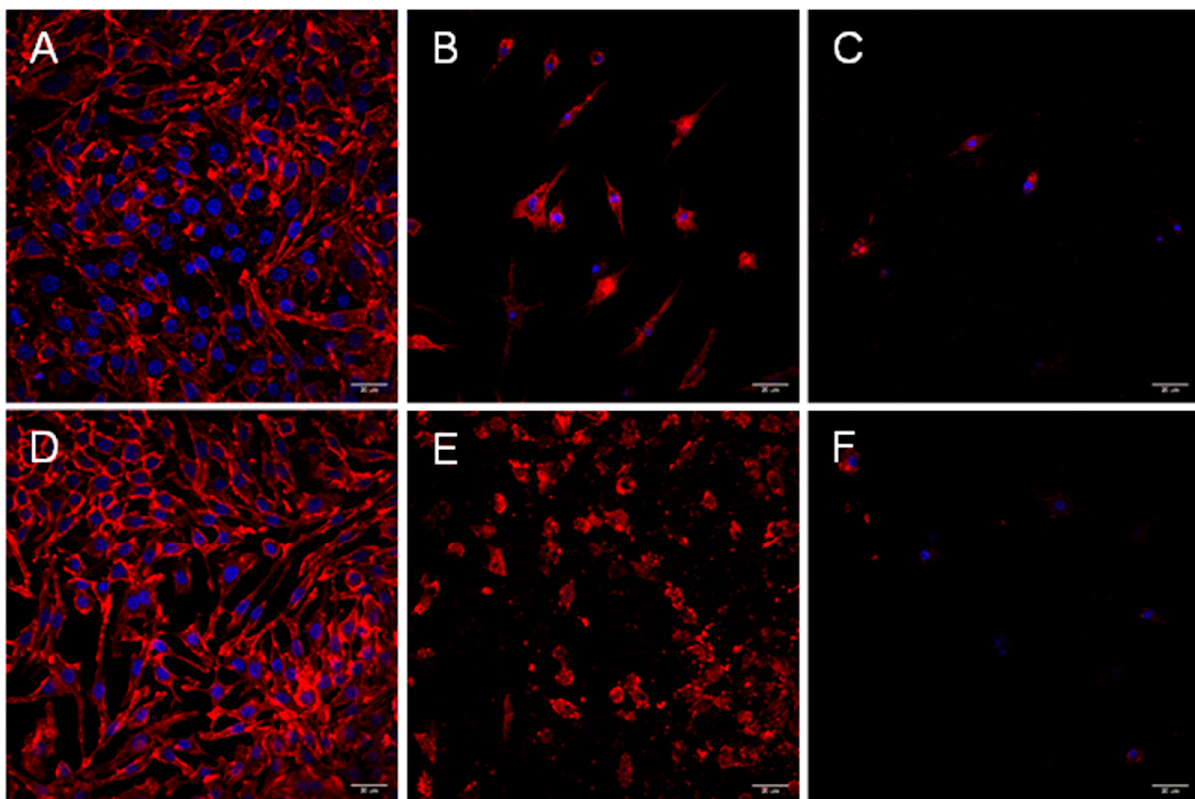
Figure 3. Aeromonas strains trigger a cytotoxic effect during infection of mouse macrophages (J774.A19). Infection was carried out in macrophages for up to 180 min with non-cytotoxic strain LE20E ( A ), cytotoxic strain CI21E ( B ), non-cytotoxic strain AG26E ( D ), and cytotoxic strain AG29E1 ( E ) for 90 min; and in CI21E ( C ) and AG29E1 ( F ) for 180 min. Cells were fixed and stained for immunofluorescence. The actin cytoskeleton was labeled with Atto 594 phalloidin (red), and the nuclei stained with DAPI (blue). Results are representative of at least three independent experiments. Micrographs were originally captured at × 400 magnification. Bars indicate 20 µ m. Table 1. Antimicrobial susceptibility testing in those strains used in this study.